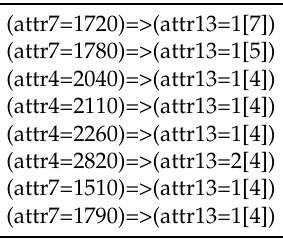
Table 5. Examples of real rules-Sequential covering algorithm, Statlog (heart) Data Set [3], Rule statistics: 199 rules, Support of rules Minimal: 1, Maximal: 7, Mean: 1.6, Length of rule premises, Minimal: 1, Maximal: